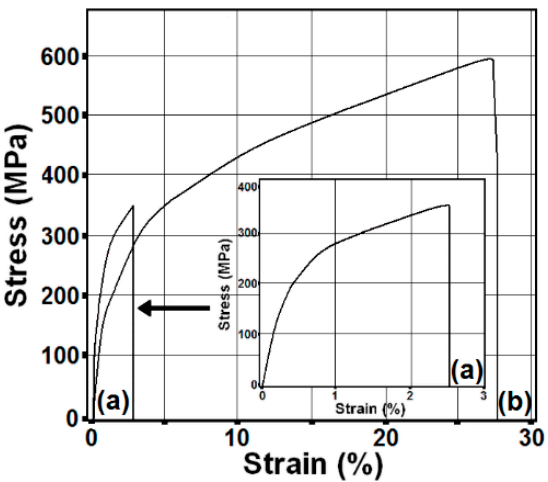
Figure 9. Stress ‐ strain curves for Co ‐ 20 wt. % Cr alloy: ( a ) in the as ‐ chill cast condition and ( b ) heat ‐ treated condition.